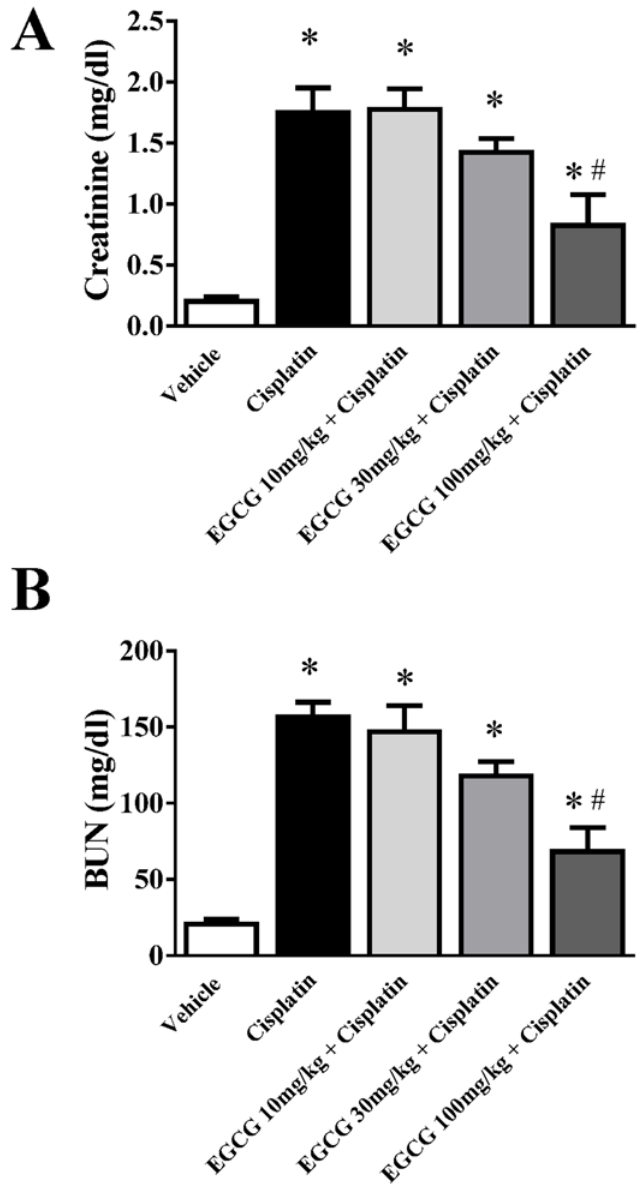
Fig 1. Effect of EGCG on cisplatin-induced renal dysfunction in mice. Cisplatin caused significant renal dysfunction as measured by the levels of creatinine (Panel A) and BUN at 72 hours (Panel B). Cisplatin administration resulted in severe kidney injury which was attenuated by EGCG treatment (at dose 100mg/kg). Results are mean ± S.E.M. n = 4/group. * p < 0.05 versus vehicle; and # p < 0.05 versus